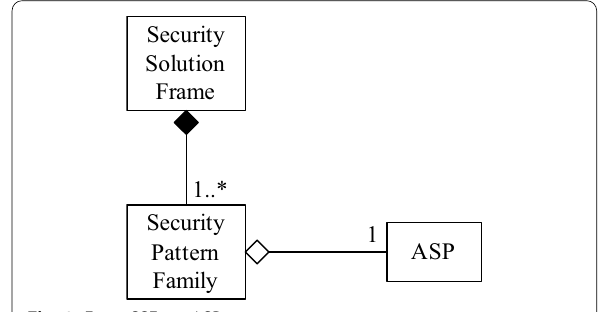
Fig. 8 From SSFs to